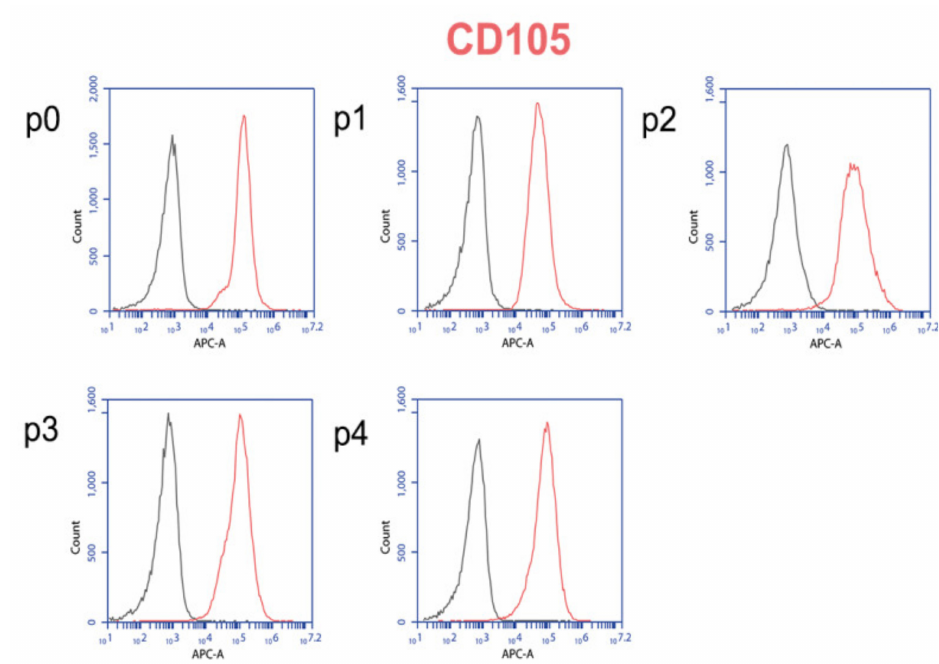
Figure 2. Flow cytometric analysis of the surface antigen CD105 on primary human myoblasts. IgG APC was used as the isotype control (black), and CD105 conjugated APC antibody (red) was used. The cell count is plotted depending on the fluorescence intensity.